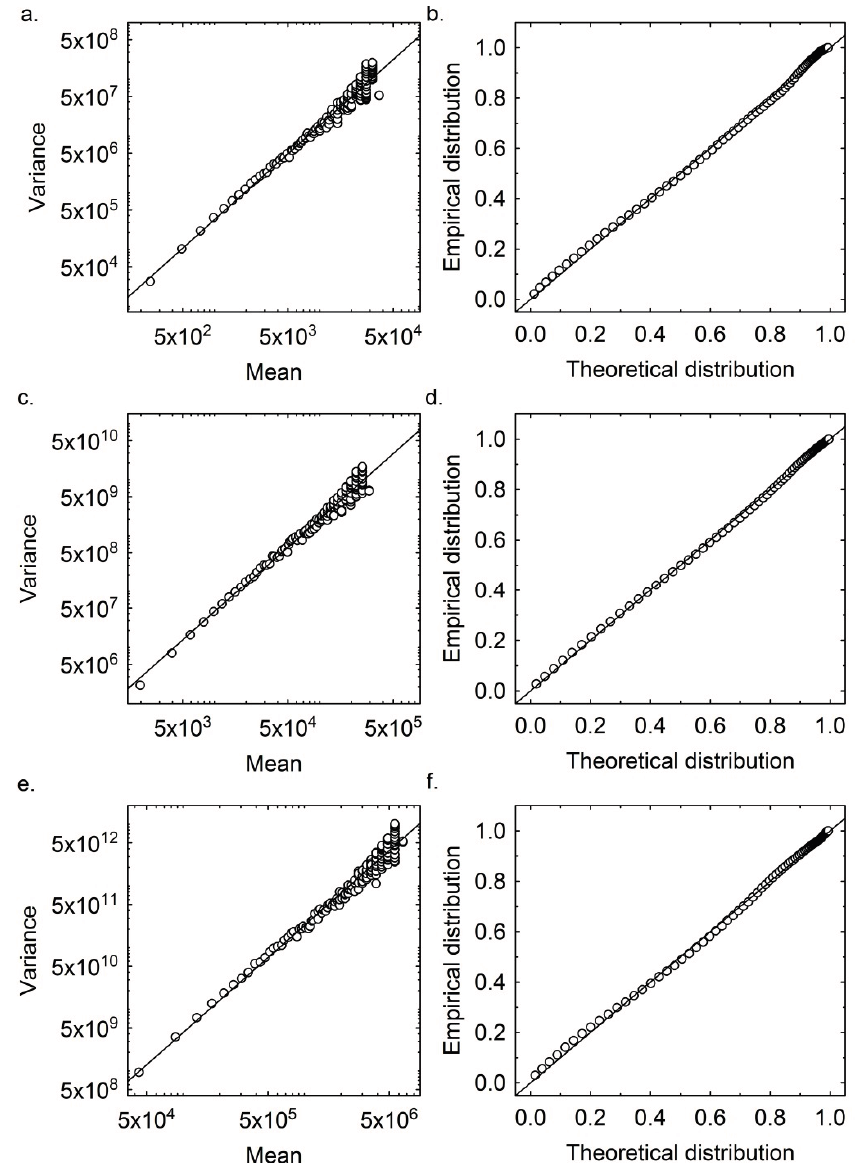
Figure 3. ( a ) Variance function of | D ( x )| for x = 10 6 …10 7 in steps of 10 3 . Linear